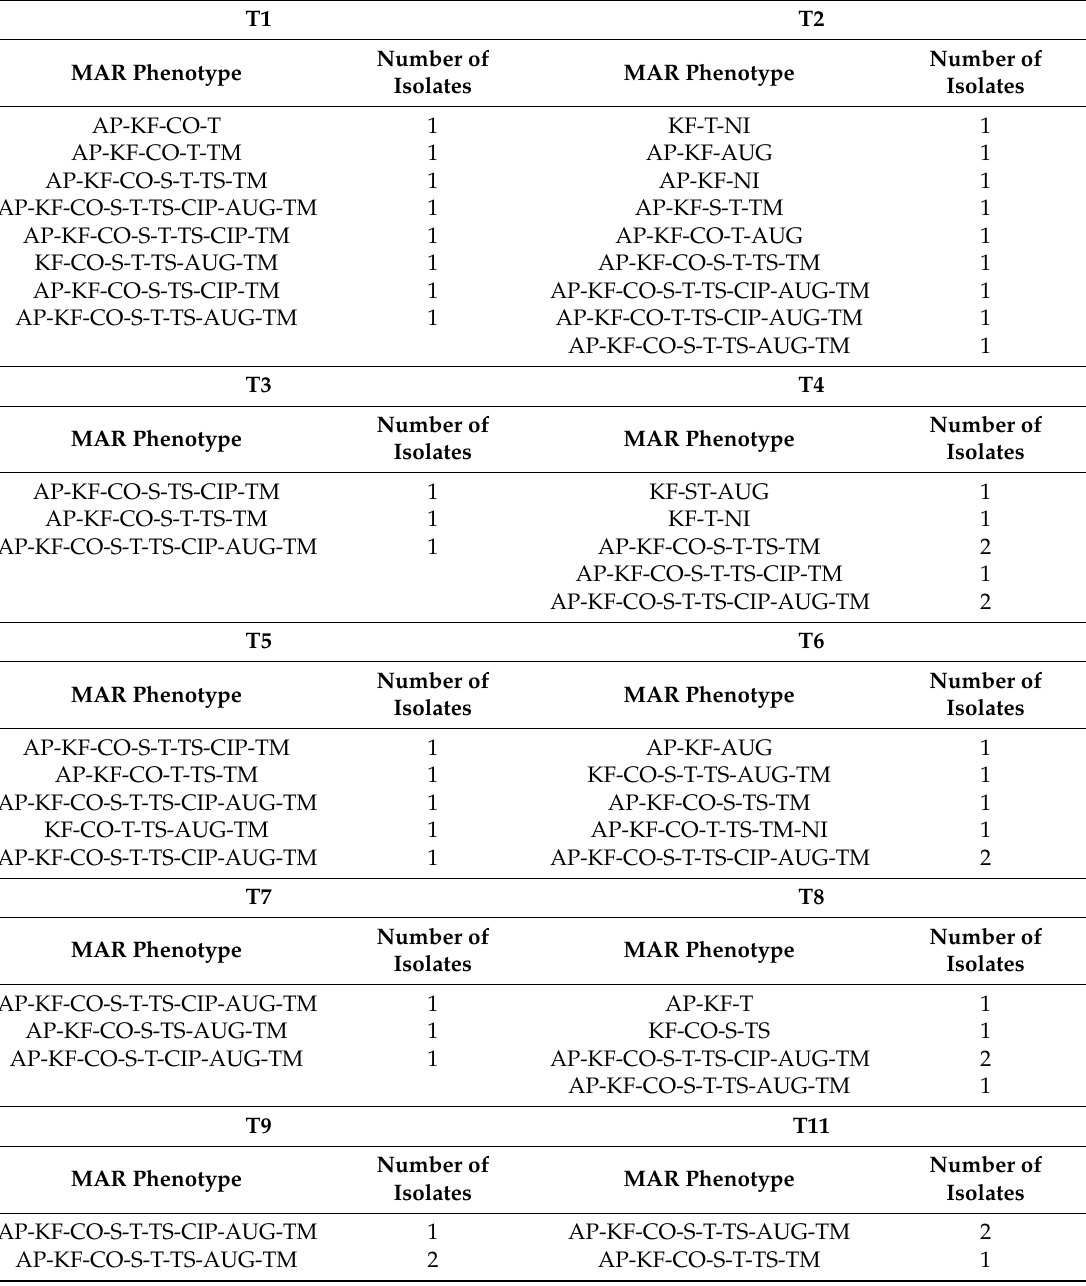
Table 5. Multiple-antibiotic-resistant phenotypes of E. coli isolated from different rainwater